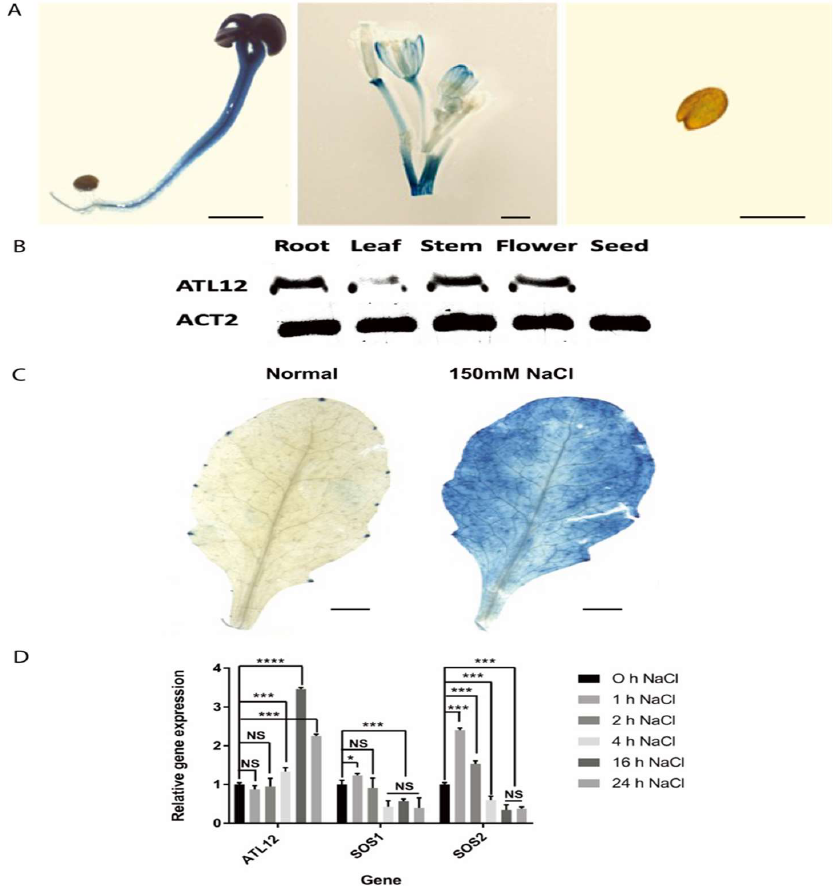
Figure 3. Expression pattern of ATL12 . ( A ) Histochemical staining analysis of p ATL12 :GUS seedlings at major organs of Col-0 . ( B ) RT-PCR analysis of ATL12 expression in major organs. Beta-ac- tin(ACT2) gene expression was used as an internal control. ( C ) Histochemical staining analysis of